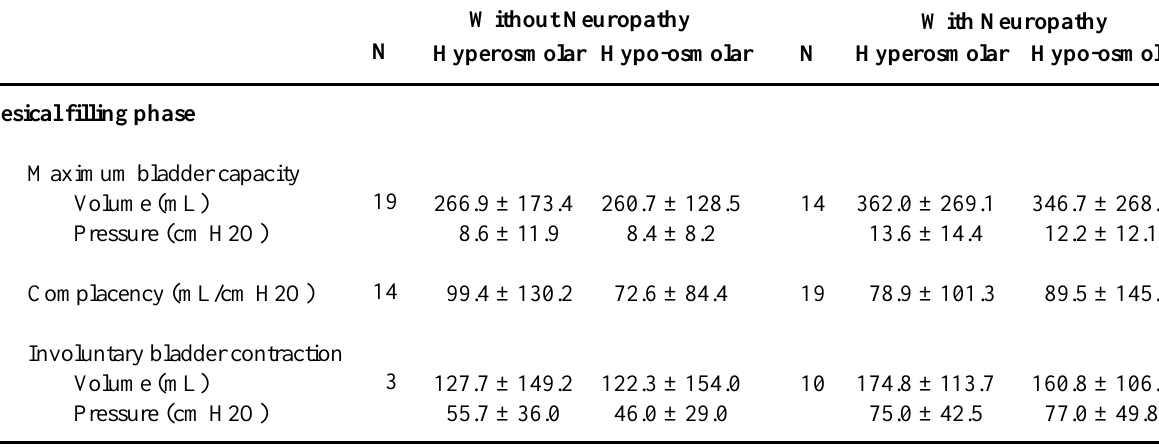
Table 5 – Values of urodynamic variables when vesical filling is accomplished with hyper- and hypo-osmolar solutions in patients with and without neuropathy (mean ± standard